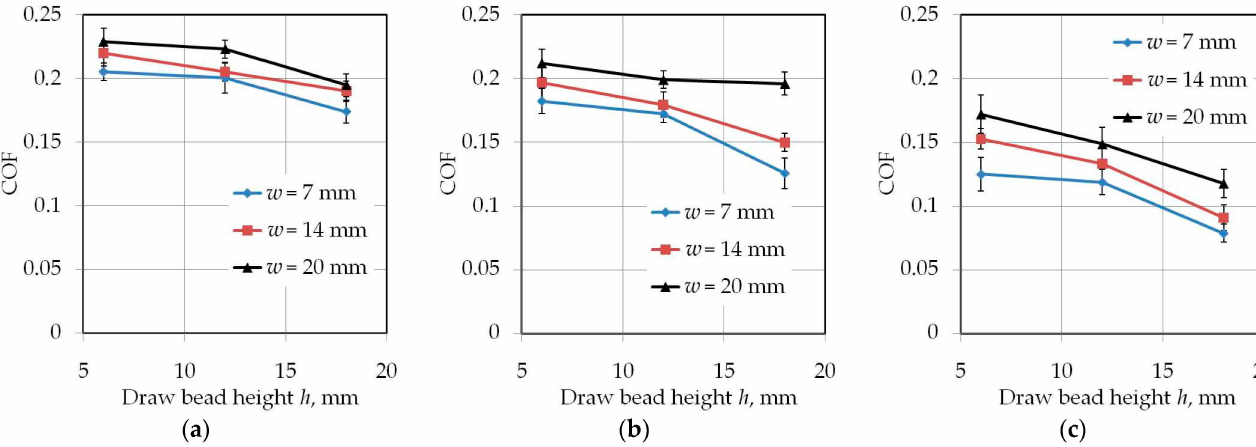
Figure 8. The effect of the drawbead height on the value of COF for specimens cut transverse to the RD (orientation 90 ◦ ):